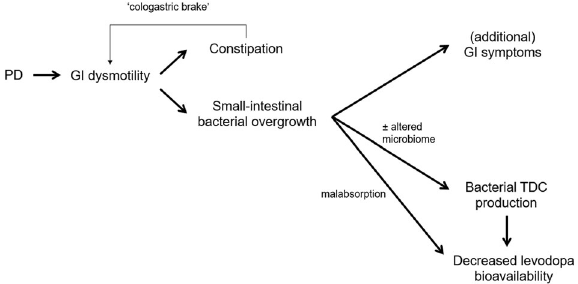
Fig. 3 Relationship between Parkinson ’ s disease, intestinal factors and decreased levodopa bioavailability. Relationship between Parkinson ’ s disease (PD), gastrointestinal (GI) function, constipation, small-intestinal bacterial overgrowth, tyrosine decar- boxylase (TDC) production, and reduced levodopa ef fi